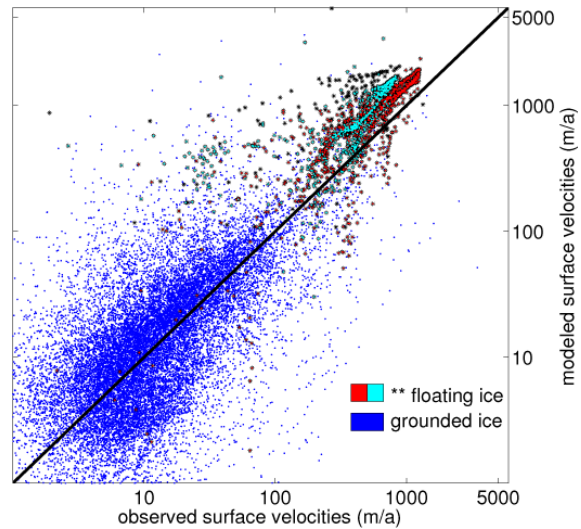
Fig. 14. Point-by-point scatterplot of modeled and observed veloc- ities. The mean difference from modeled to observed velocities for grounded points is ≈ 4ma − 1 with a standard deviation from this mean difference of ≈ 81ma − 1 . For floating points we get a larger difference of ≈ 334ma − 1 with a standard deviation of ≈ 309ma − 1 . The stars with red points are the floating velocities that belong to the Ronne-Filchner Ice-Shelf, while the ones with the cyan points be- long to the Ross Ice Shelf.